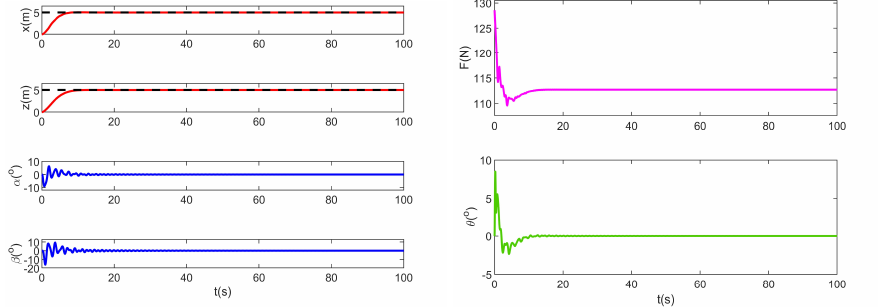
Figure 4. Simulations results for PD control method.